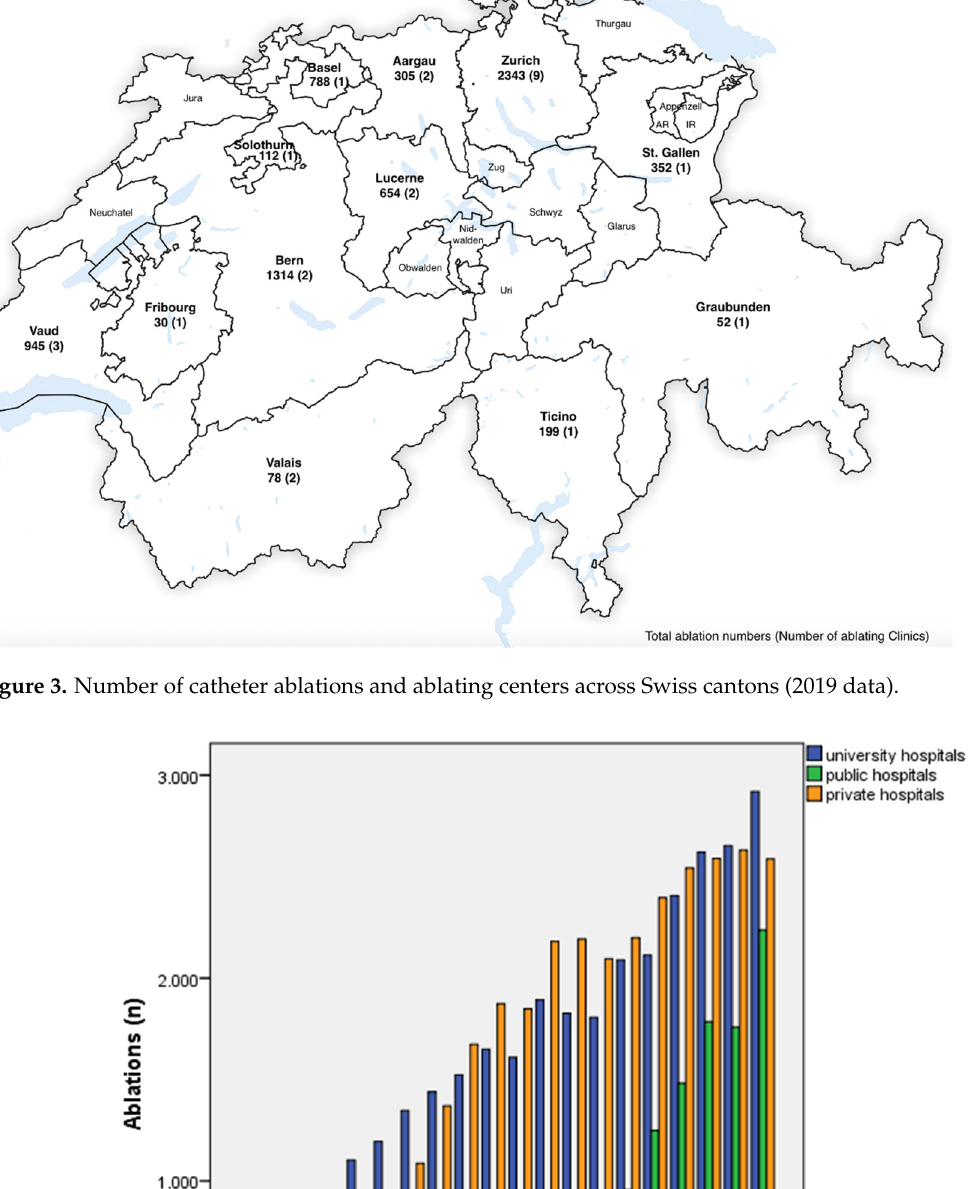
Figure 4. Ablations distributed to ablating centers from 2000 till the end of 2019.